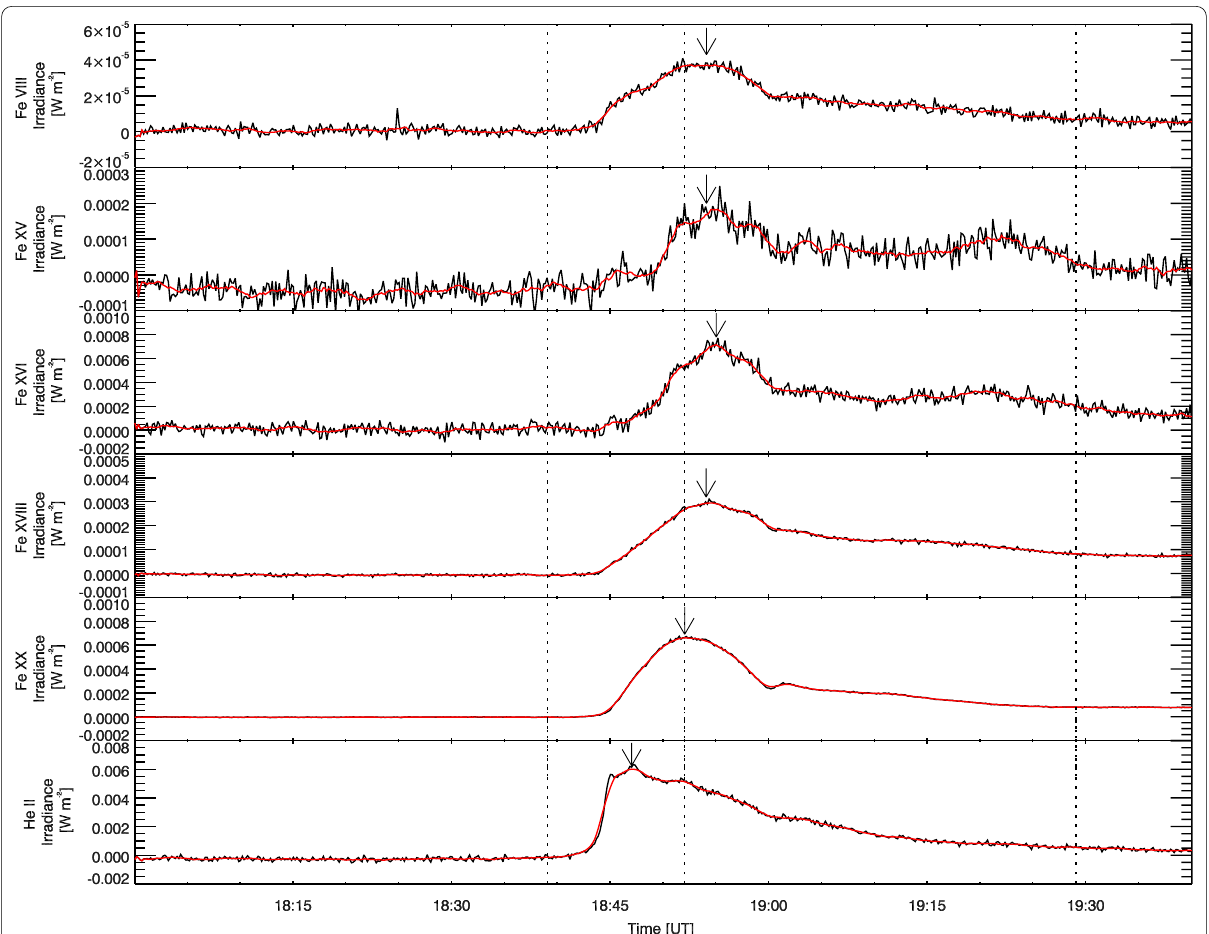
Fig. 3 Examples of EUV flare line light curves. The light curves of each EUV flare line [Fe VIII, Fe XV, Fe XVI, Fe XVIII, Fe XX, and He II from the top to bottom panels] observed by the SDO/EVE MEGS-A for the M9.9-class flare on January 1, 2014. The solid black lines indicate the observed values with a 10 s cadence. The solid red lines indicate the 110 s running average values of the observed data. The 3-min average values (18:00–18:03) during the non-enhanced at the beginning of the hour before the flare were subtracted from each light curve as background. Each vertical dotted line indicates the flare start time, peak time, and end time, respectively, from left to right. The arrows indicate the peak times for each EUV flare